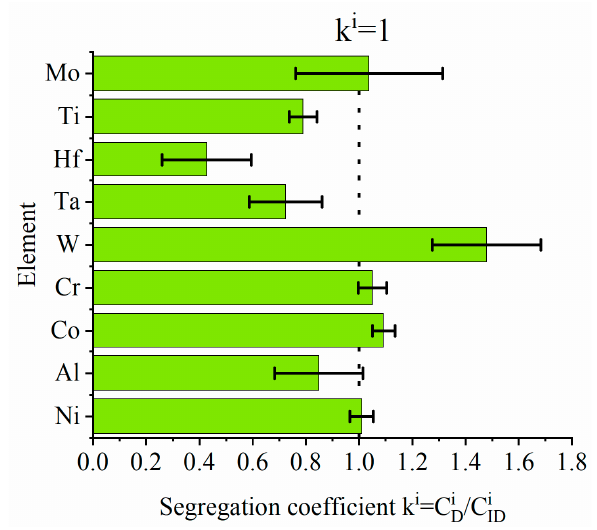
i D of selected alloying elements. (cid:2887) (cid:3136)(cid:3167) of selected alloying elements. C i ID (cid:2887) (cid:3141)(cid:3136)(cid:3167)